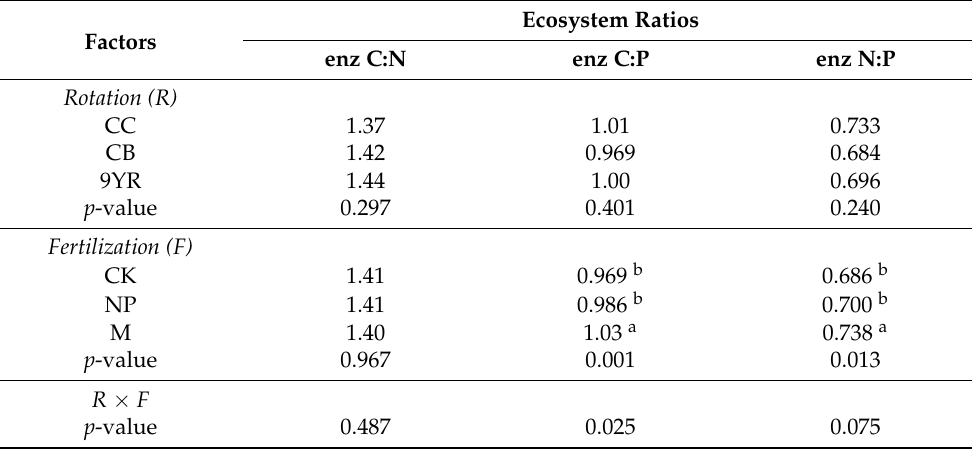
Table 3. Marginal means of soil ecosystem ratios for rotation and fertilization effects. Different upper- case and lower-case letters indicate significant differences ( p -value < 0.05), respectively, between rotation and between fertilization as determined by the Fisher’s LSD test.